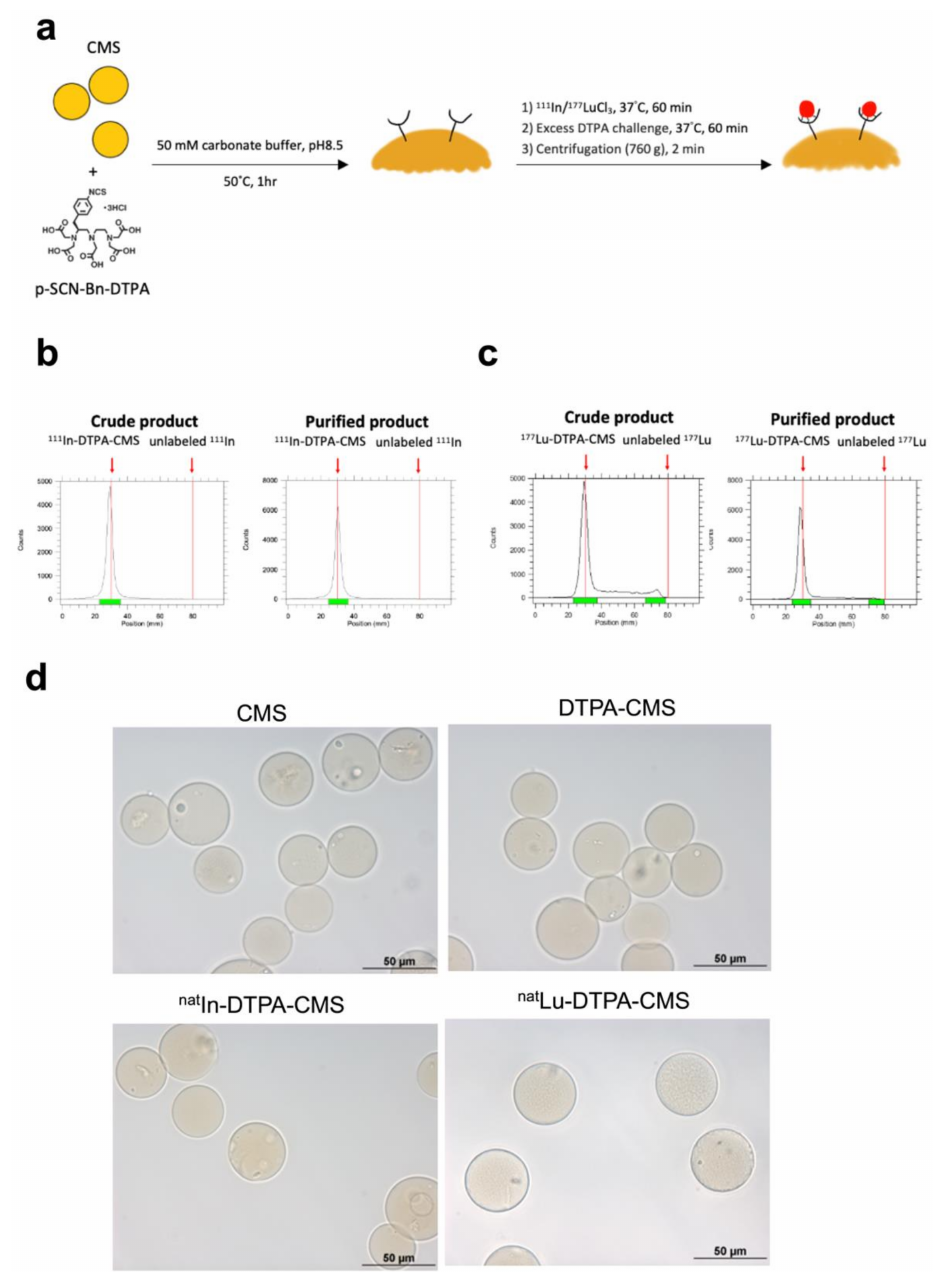
Figure 2. Preparation of radiolabeled chitosan microspheres. ( a ) The schematic diagram of radiolabel- ing. RadioTLC graphs of ( b ) 111 In-DTPA-CMS and ( c ) 177 Lu-DTPA-CMS before and after purification. Retention factor (Rf) values of 111 In-DTPA-CMS, 111 In-DTPA-CMS, unlabeled radioactive 111 In, and unlabeled radioactive 177 Lu are 0, 0, 1, and 1, respectively. ( d ) The size of unmodified chitosan mi- crospheres (CMS), DTPA-modified chitosan microspheres (DTPA-CMS), and chitosan microspheres labeled with naturally existing indium ( nat In-DTPA-CMS) and lutetium ( nat Lu-DTPA-CMS). The images were obtained from a bright-field